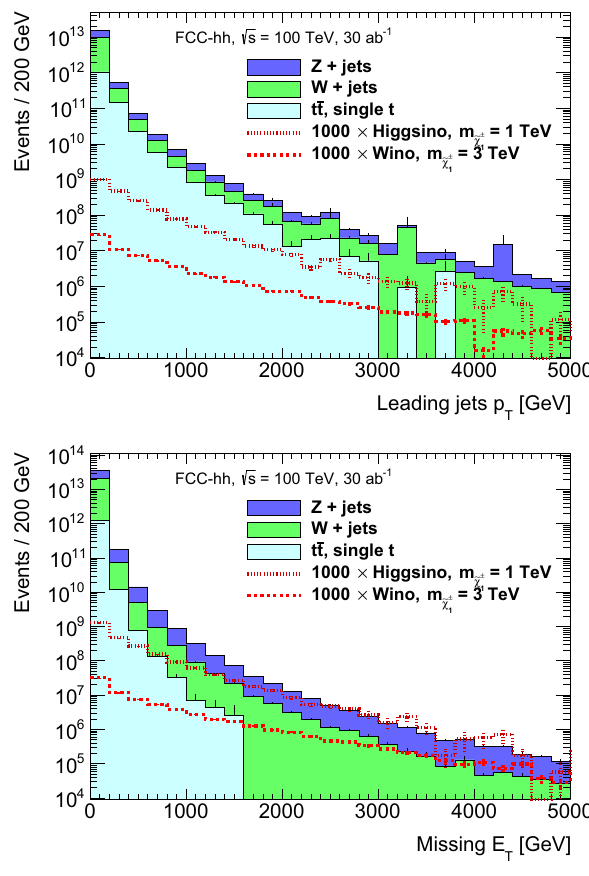
Fig. 2 Leading jet p T (top) and E miss removing events containing isolated leptons with 30 ab − 1 at 100 TeV. The SM backgrounds from W / Z +jets and top production processes are shown as filled histograms. Also shown as dashed (dot- ted) line is the 3 (1) TeV wino (higgsino) signal scaled up by a factor 1000